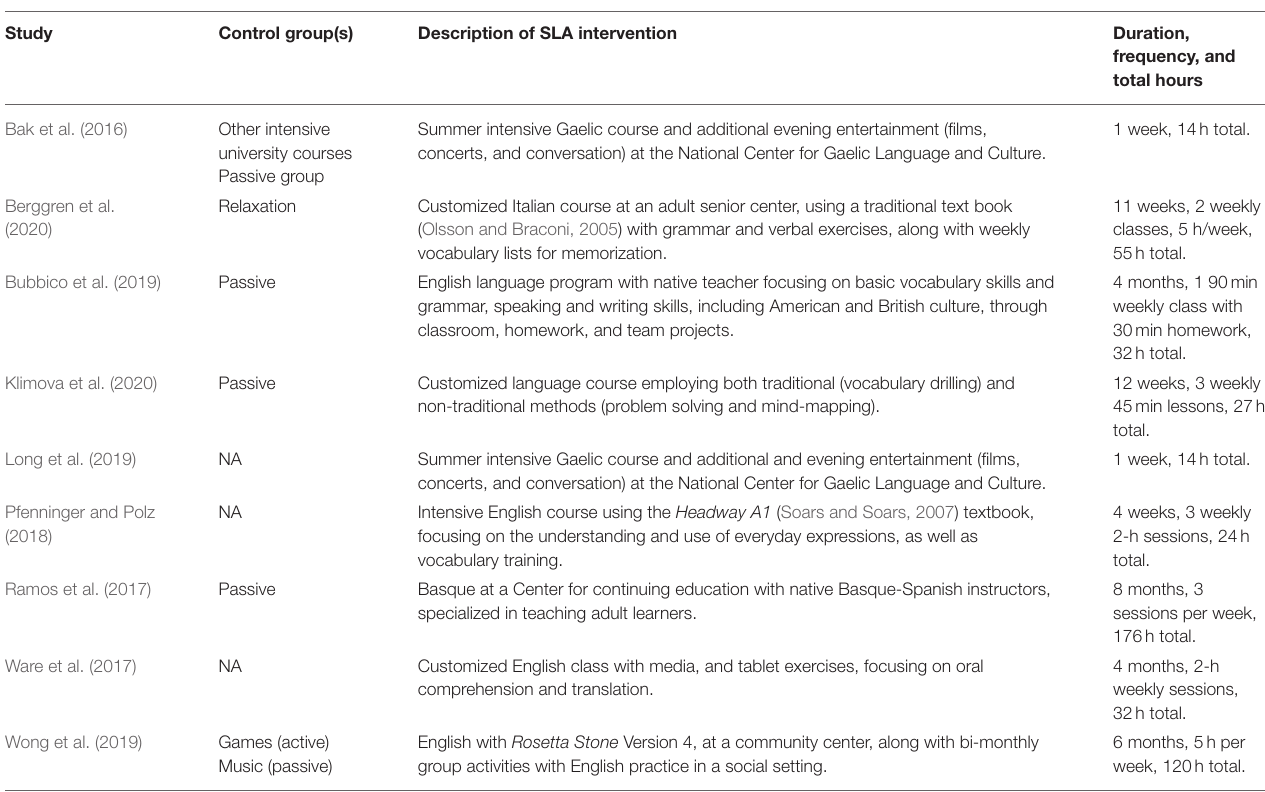
TABLE 3 | Detailed description of